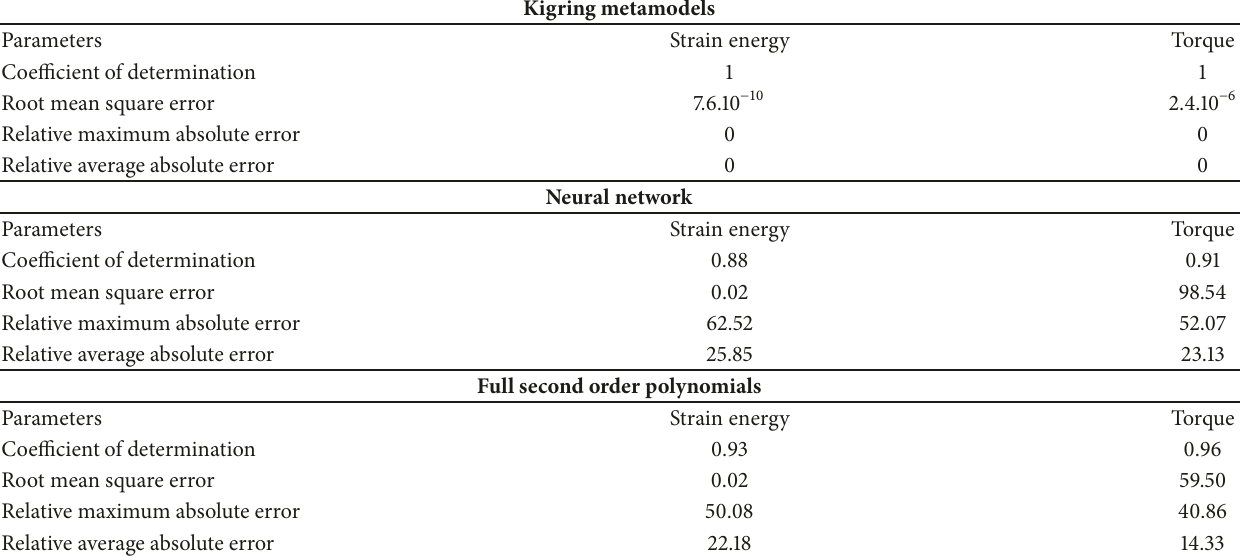
Table 4: The goodness-of-fit of the Kigring response